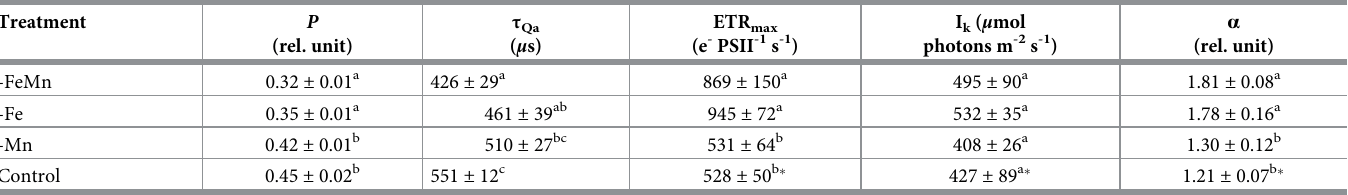
Table 2. Connectivity between adjacent photosystems ( p ), time constant for electron transfer at PSII ( τ Qa ), absolute maximum electron transport rates (ETR max ), light saturation point (I k ) and light use efficiency ( α ) were measured for C . debilis grown in naturally FeMn-poor Antarctic seawater (-FeMn) and to which additions of either Mn alone (-Fe), Fe alone (-Mn) or both (control) were given. Values represent the means ± SD (n = 3). Different letters indicate significant differences between treatments ( p <